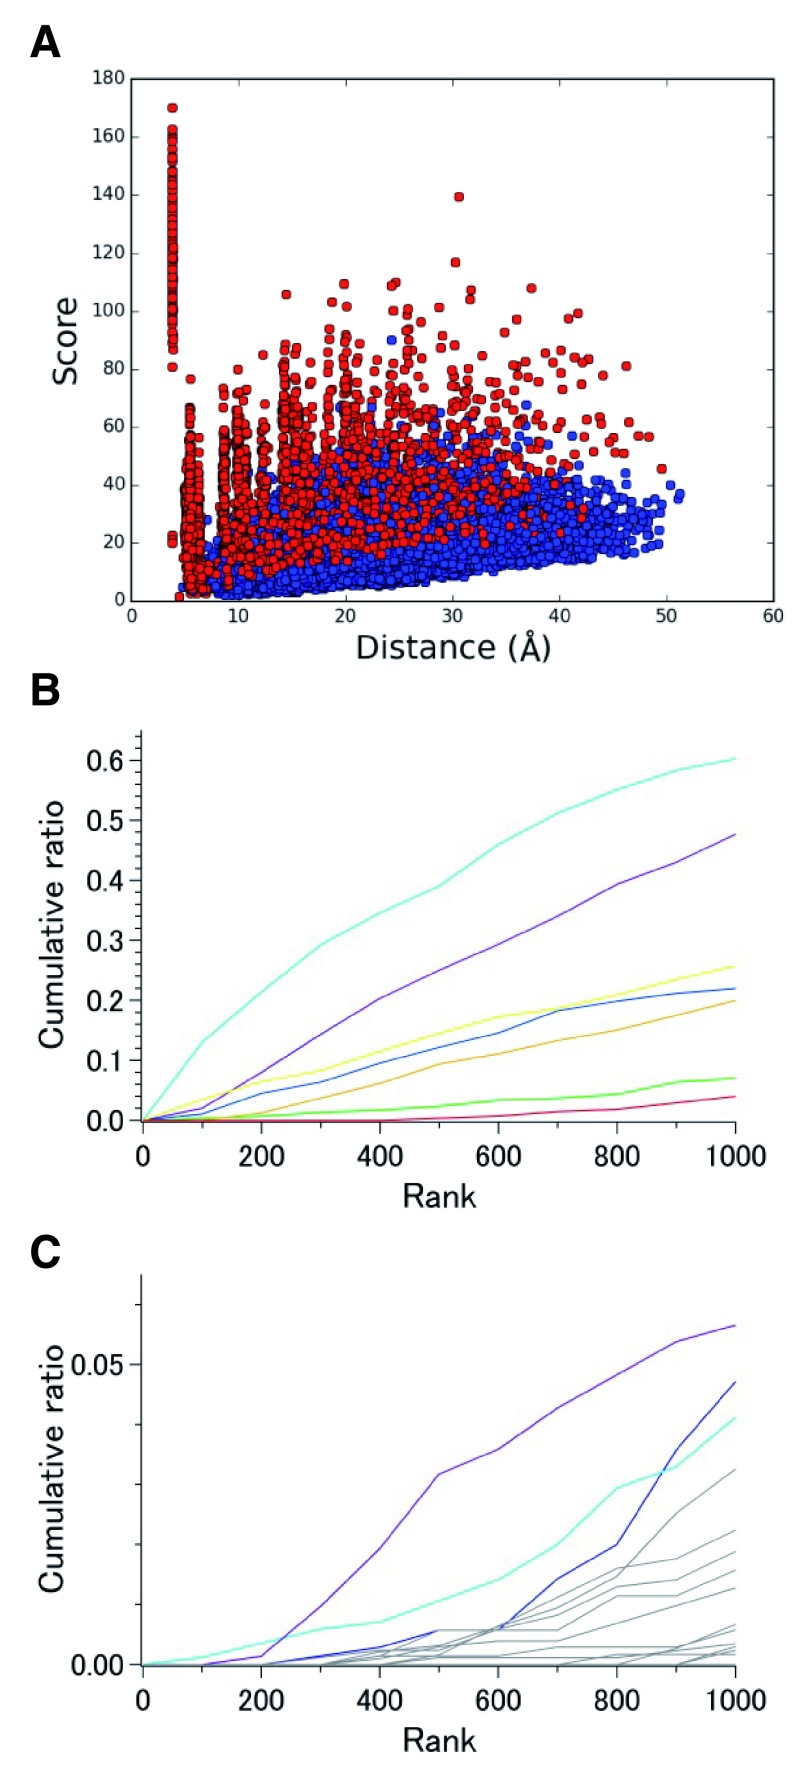
DSA results for all 18,915 C
α−C
α pairs in the updated set of GPCRs containing 23 unique receptor chains.(
A) Correlation between score and average distance. Intrahelical and interhelical C
α−C
α pairs are colored in red and blue, respectively. (
B) Cumulative ratio of the number of 2,661 intrahelical C
α−C
α pairs in the top-ranked 1,000. Coloring of the plots is the same as that used in
Figure 3. (
C) Cumulative ratio of the number of 16,254 interhelical C
α−C
α pairs in the top-ranked 1,000. Purple, I-VI; cyan, I-III, blue, I-II; gray, others.